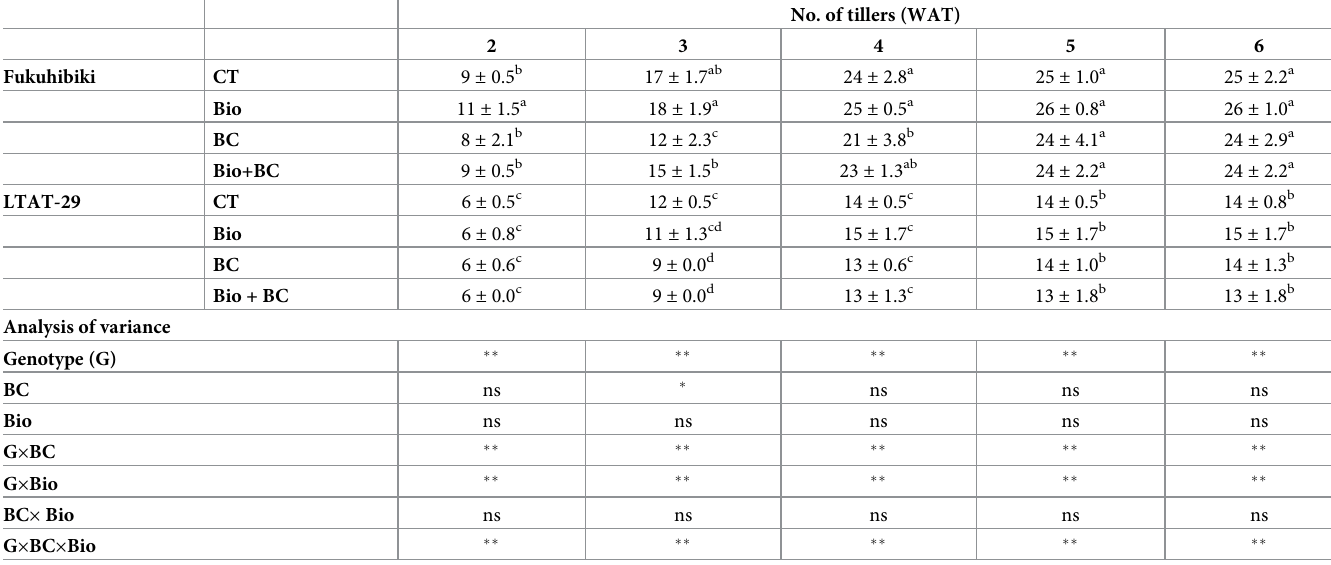
Table 4. Effect of TUAT-1 biofertilizer, biochar, and their combination treatments on tiller number at different growth stages of two rice genotypes.